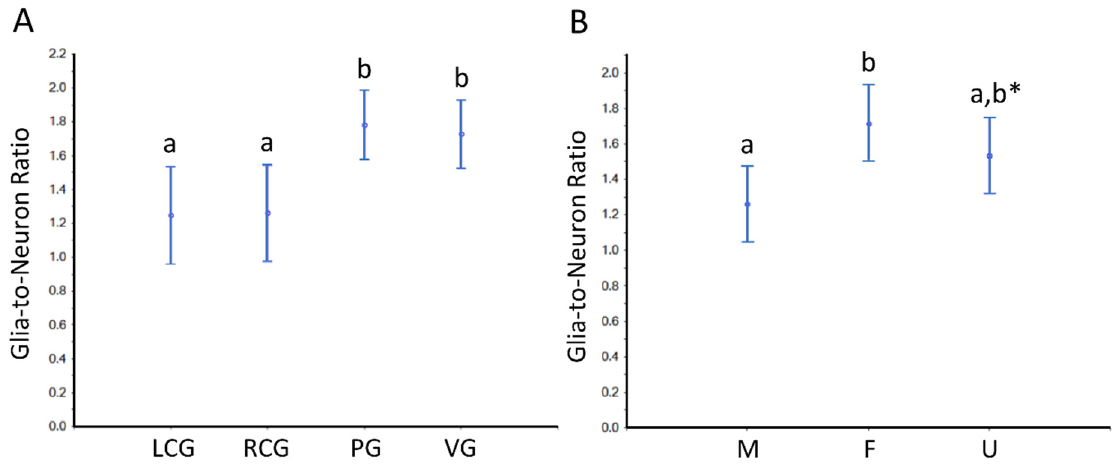
Figure 10. Glia-to-neuron (number) ratio in the ganglia of S. plana , considering the whole ganglia. ( A ) Data per ganglion type, irrespective of sex condition. ( B ) Results from all ganglia, grouped per sex condition. Different letters mean significant differences ( p < 0.05). Data as mean and 95% confidence interval. LCG: left cerebral ganglion; RCG: right cerebral ganglion; PG: pedal ganglion; VG: visceral ganglion; M: males; F: females; U: undifferentiated. * Trend towards a significant difference between M and U ( p ≈ 0.05). Six animals per sex condition were used.